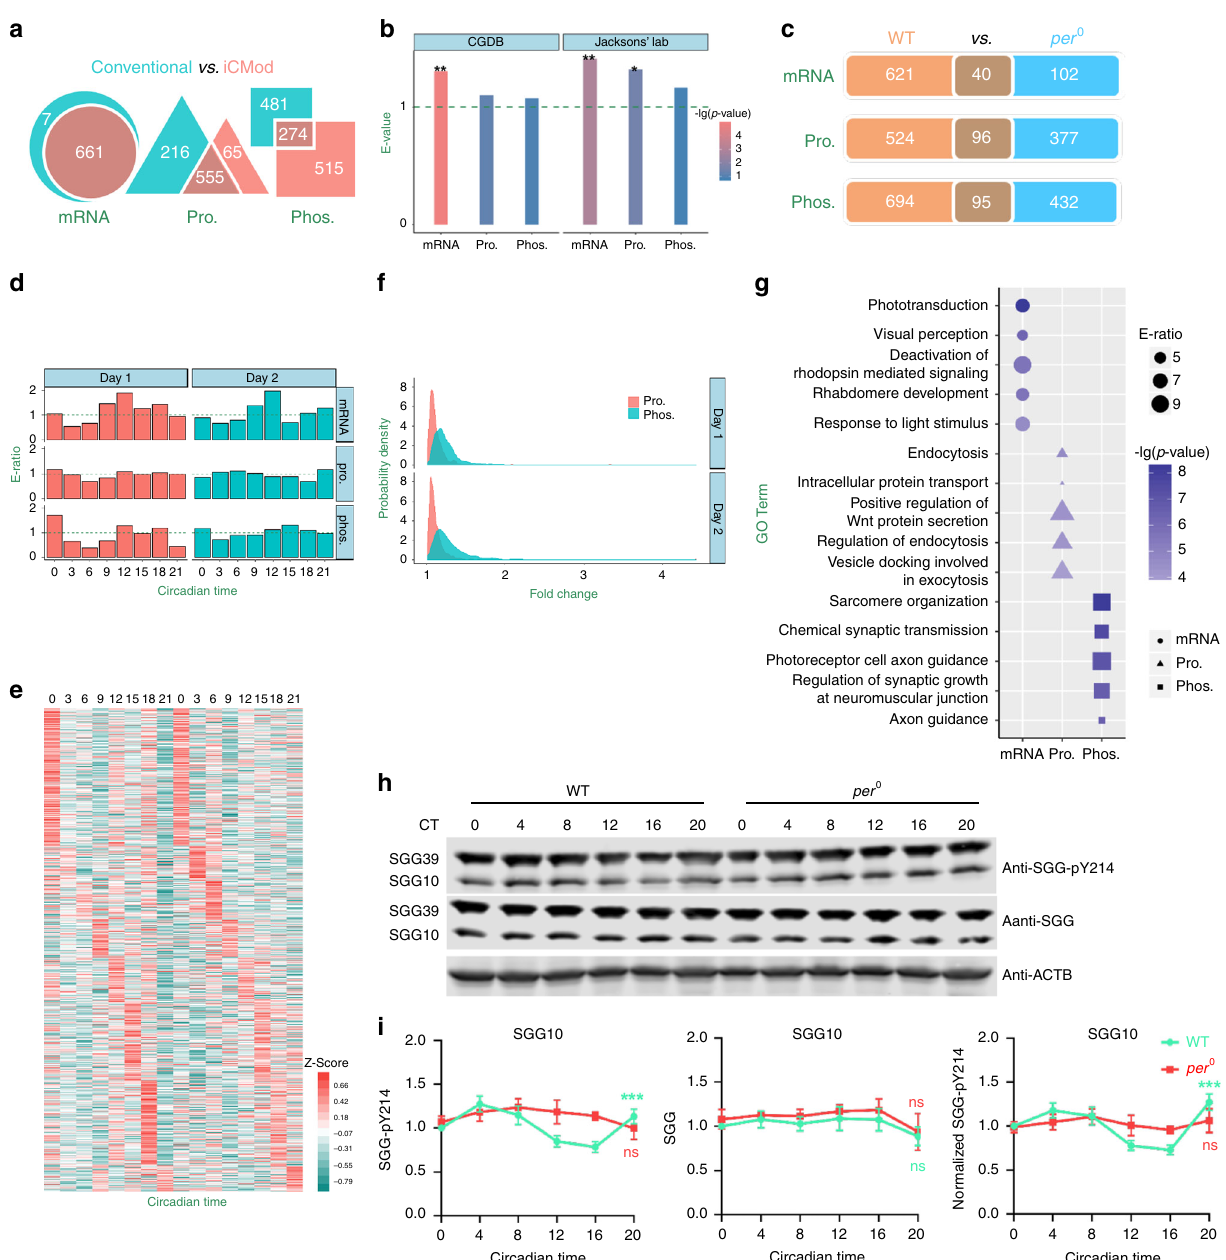
Fig. 3 Molecular oscillation landscapes uncovered by iCMod. a Cycling mRNAs, proteins, and p-sites identi fi ed by iCMod vs. commonly used approach. b The enrichment analyses of 2768 transcriptionally rhythmic genes collected in CGDB 23 and 1255 translationally oscillated mRNAs obtained from a previously reported ribosomal pro fi ling against circadian mRNAs, proteins, and phosphoproteins detected by iCMod (two-sided hypergeometric test, from left to right, p value = 0.00001, 0.0614, 0.1299, 0.0013, 0.0305, and 0.1572; ** p value < 0.01, * p value < 0.05). c Cycling mRNAs, proteins and NCPs identi fi ed in WT and per 0 fl ies. d The enrichment ratio of NCPs that peak at a certain time point. e A hierarchical clustering of the NCPs ordered by the phase of the oscillation. Values of each NCP in all analyzed samples (column) are color coded based on the intensities. Colors indicate low (green) and high (red) Z scores. f The distribution of fold-changes for cycling proteins and NCPs. g The GO-based enrichment analysis of cycling mRNAs, proteins and NCPs (Two-sided hypergeometric test, p value of mRNA < 2.2 × 10 − 5 , p value of Pro. < 1.4 × 10 − 4 and p value of Phos. < 3.1 × 10 − 7 ). h Western blots of proteins from whole-head extracts of WT and per 0 collected at the indicated circadian time. ACTB was used as a loading control. SGG10 and SGG39 indicate different isoforms of SGG. Repeated fi ve to seven times independently with similar results. i Quanti fi cation of SGG pY214 ( n = 7), SGG protein ( n = 5) and normalized SGG pY214 ( n = 7) levels of blots in h . Error bars represent standard error of the mean (SEM). SGG pY214 of WT, one-way ANOVA, *** p value = 0.00033; SGG pY214, one-way ANOVA of WT, * ** p value = 0.00002; ns, not signi fi cant. Source data are provided as a Source Data fi